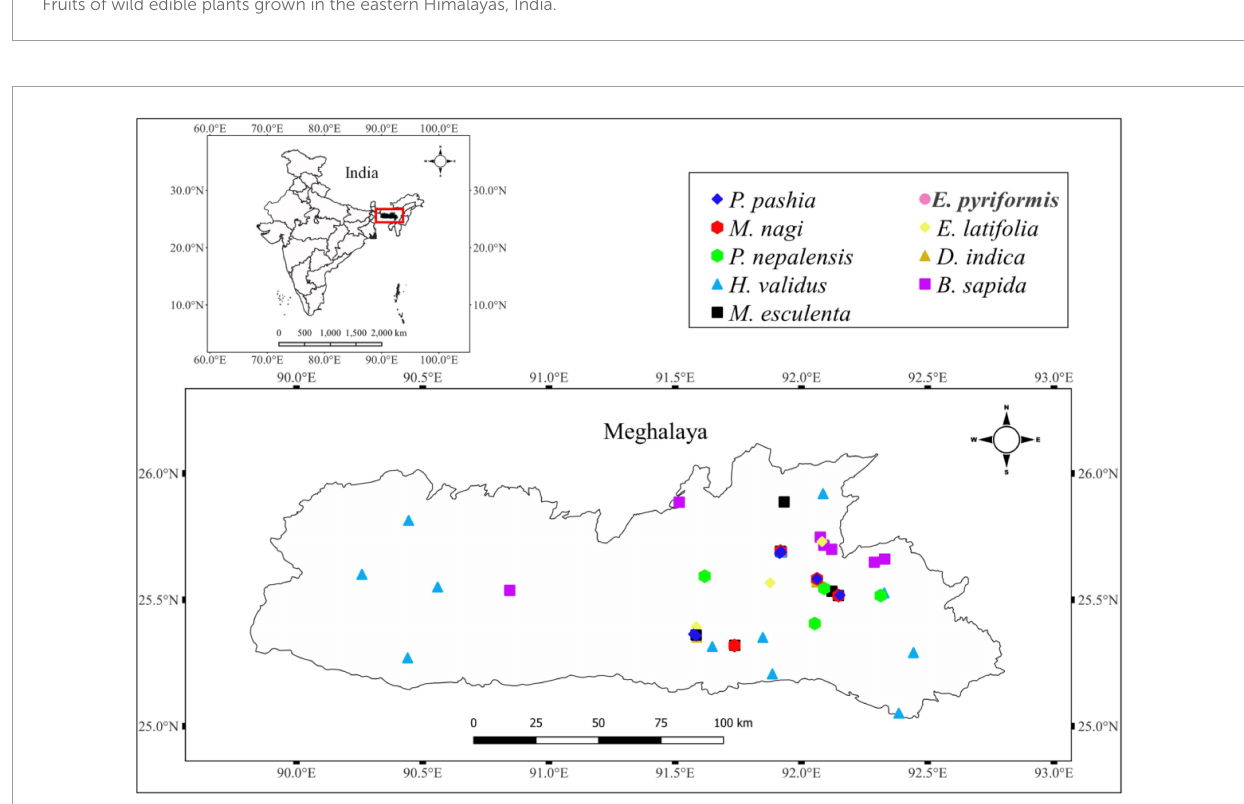
FIGURE2 Collection sites of wild edible fruits grown in the eastern Himalayas, India (Generated by subjected the global positioning system (GPS) data to quantum geographic information system (QGIS) version 3.20.1).